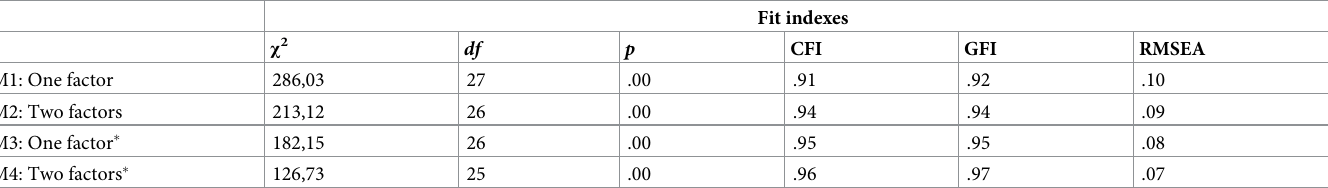
Table 3. Model fit.